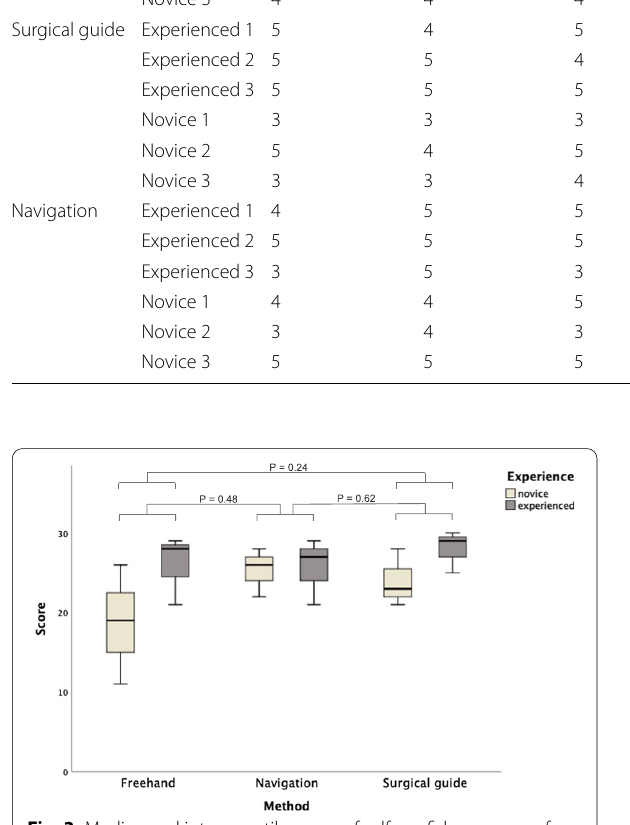
Fig. 3 Median and inter-quartile range of self-confidence scores for each approach categorized by experience. Boxes comprise of 25th and 75th quartiles and median values, upper and lower whisker indicate highest and lowest